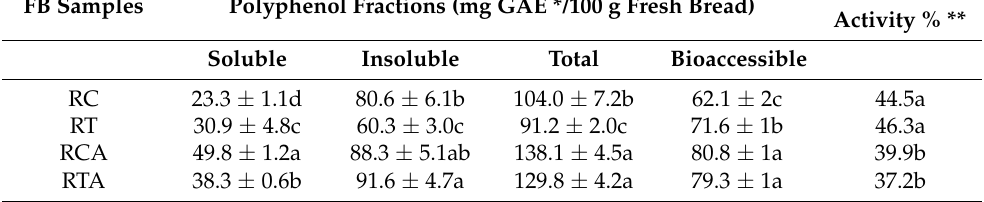
Table 6. Mean values and standard deviations of polyphenol fraction and antioxidant activity % of FB samples.